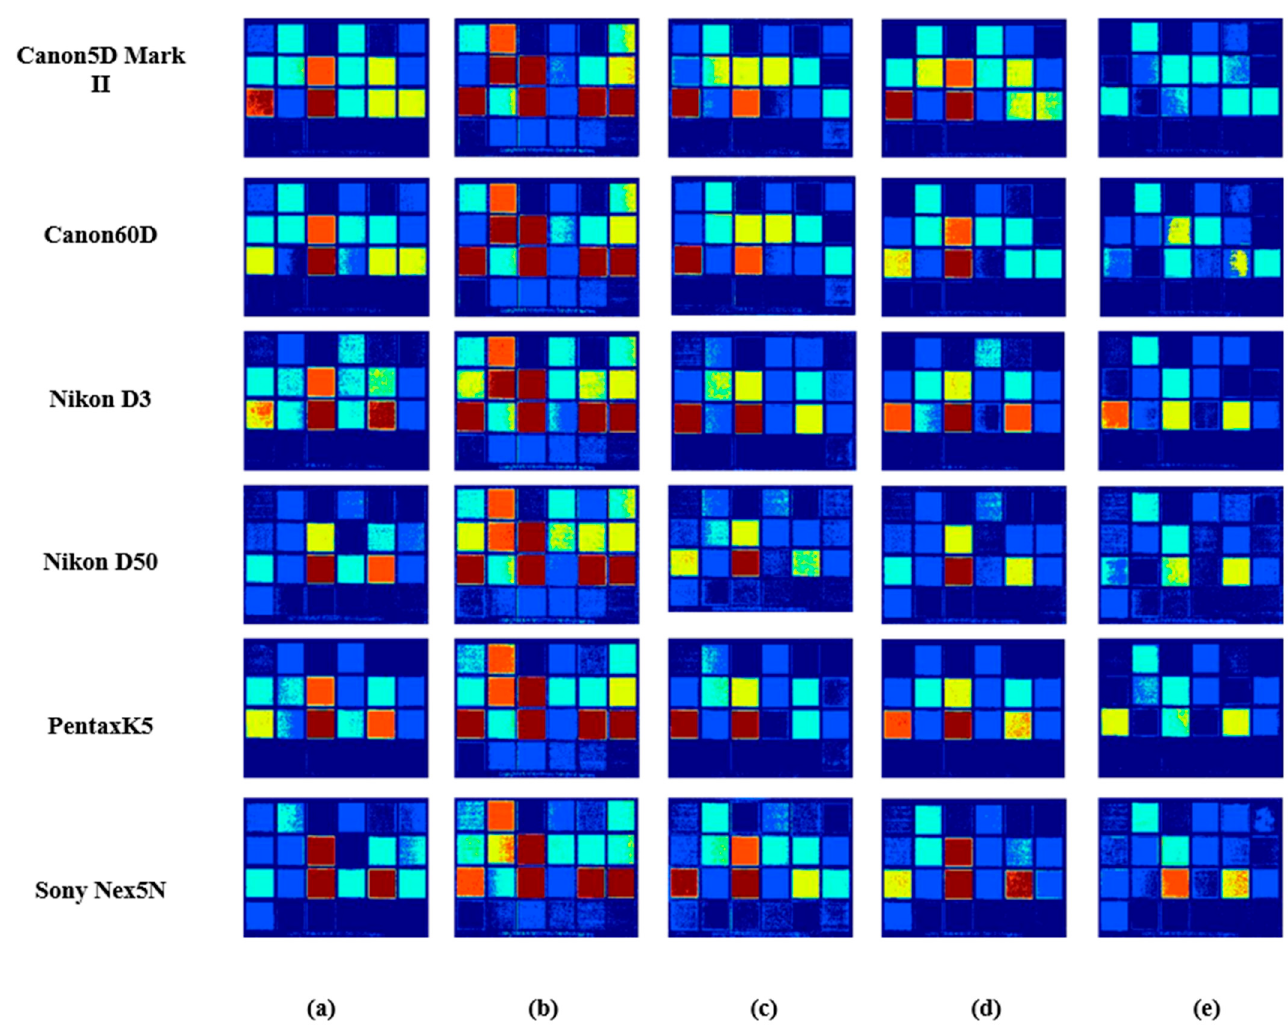
Figure 14. Results comparison of ColorChecker spectral images in different methods using six spectral sensitivity functions as the spectral sensitivity: ( a ) PI, ( b ) PCA, ( c ) Wang [37], ( d ) Zhang [32] and ( e ) the proposed.